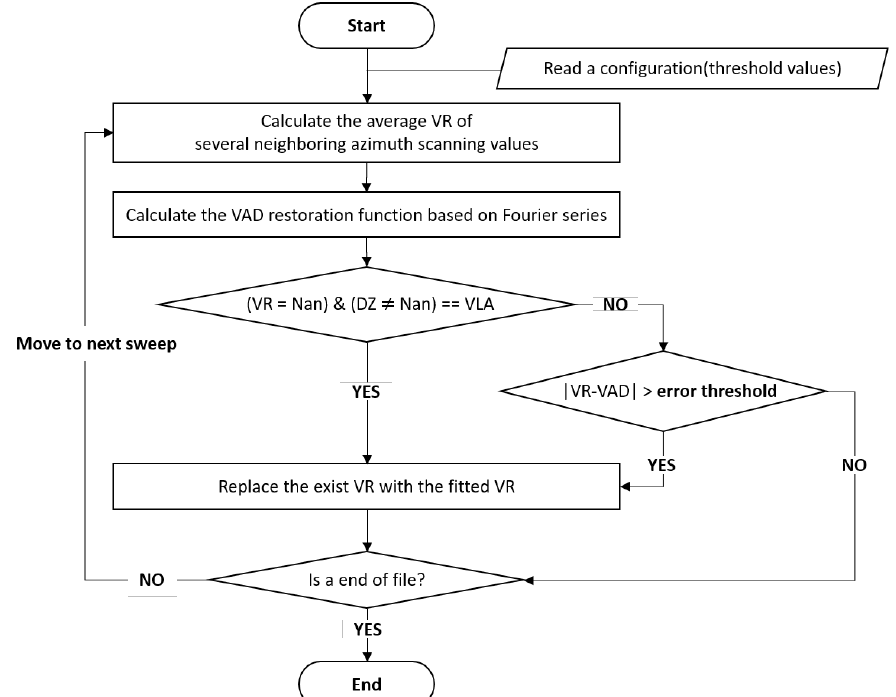
Figure 5. Flowchart of a retrieval algorithm for lost radial